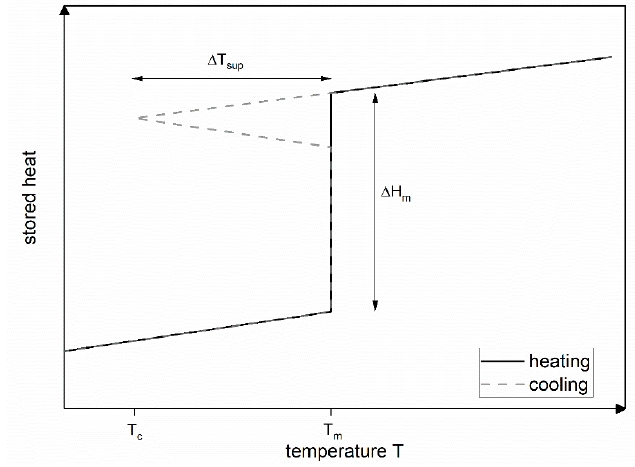
Figure 1. Exemplary depiction of the supplied heat above the material temperature with a represen- tation of the melting enthalpy Δ H m and supercooling during the cooling process Δ T sup .